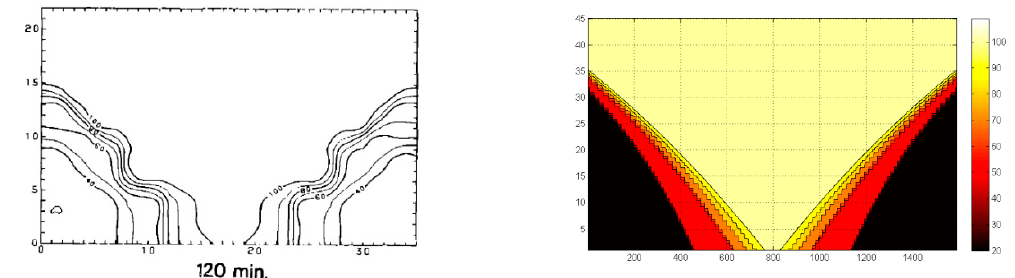
Figure 8. The temperature distribution inside the reservoir at three times: 60 min, 90 min, and 120 min after steam injection in centigrade degrees. The figure compares the computer outputs with experimental screenshots.